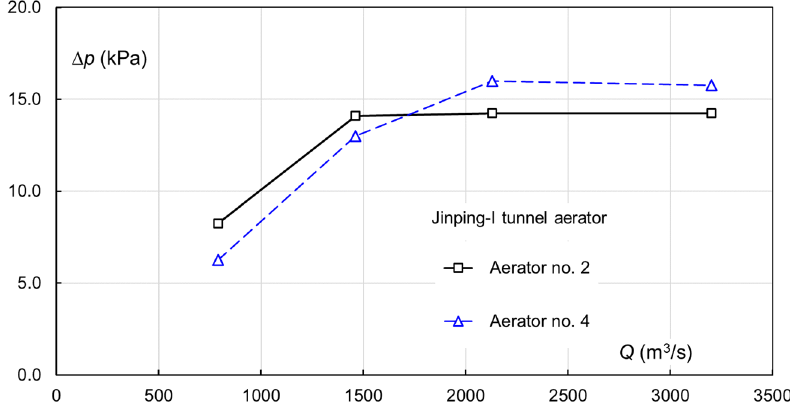
Figure 13. Jinping ‐ I aerators, pressure drop in the air cavities ( Δ p ) from the prototype measurements Figure 13. Jinping-I aerators, pressure drop in the air cavities ( ∆ p ) from the prototype measurements (based on the data in [15]). (based on the data in